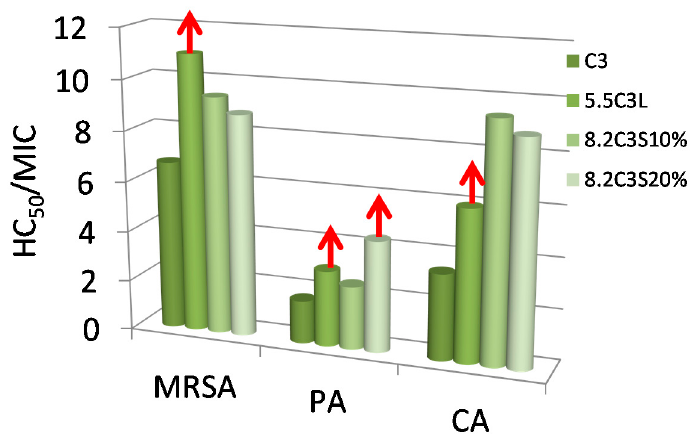
Figure 9. Therapeutic Index ( HC 50 / MIC ) of C 3 CA 2 and some of their catanionic mixtures against a Gram-positive bacteria (MRSA), a Gram-negative ( P. aeruginosa (PA)) and a yeast ( C. albicans (CA)). Arrows indicate that the TI is greater than or equal to the value in the figure.